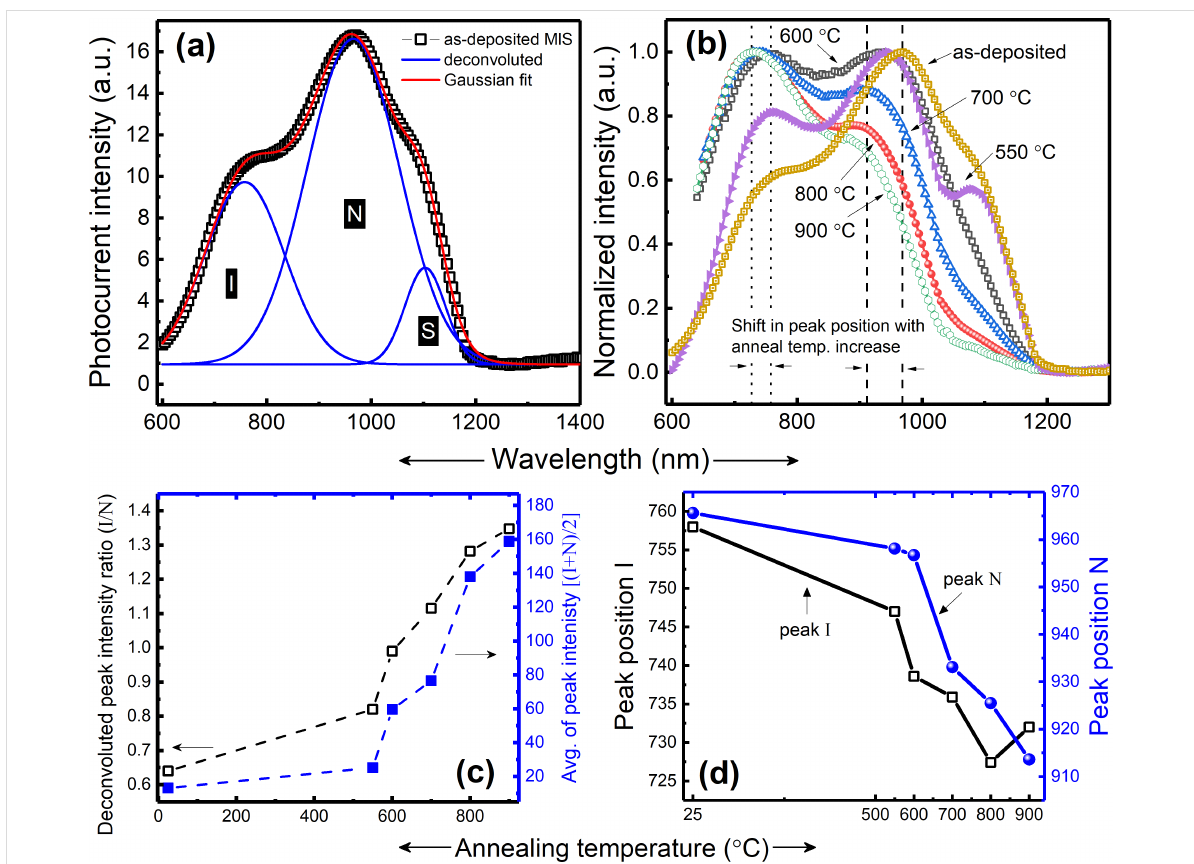
Figure 7: (a) Deconvoluted (Gaussian fit) room-temperature photocurrent spectra of as-grown MLs. (b) Normalized photocurrent spectra of annealed (550–900 °C) and as-grown MLs (the dotted line in the plot represents a blue-shift in peak position with increased annealing temperature). (c) Double y -axis plot, with left y -axis for alteration in intensity of peak I with respect to peak N (i.e., peak I/N) and right y -axis showing an increase in spectral in- tensity as an average of peaks [(I + N)/2], as a function of the annealing temperature. (d) Peak positions of curves I and N as functions of the temper- ature for a fixed annealing time of 1 min (values obtained by deconvoluting the